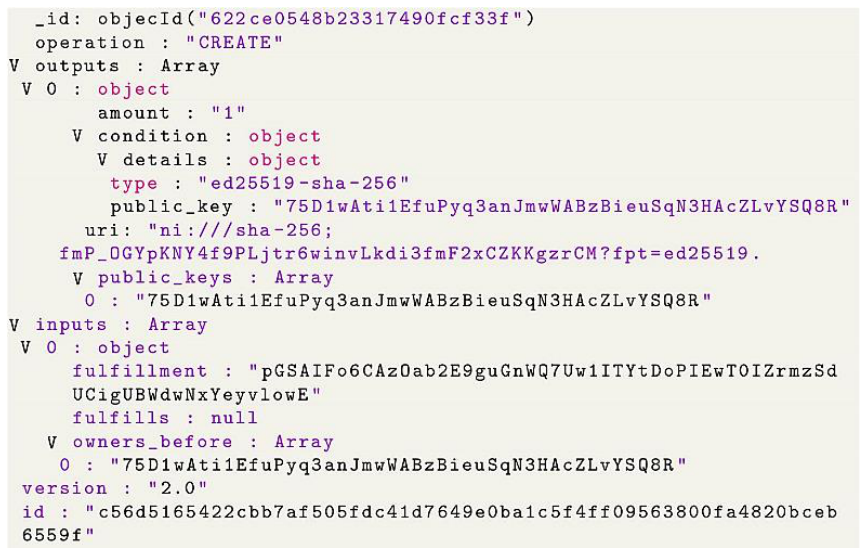
Figure 13. Create Transaction.